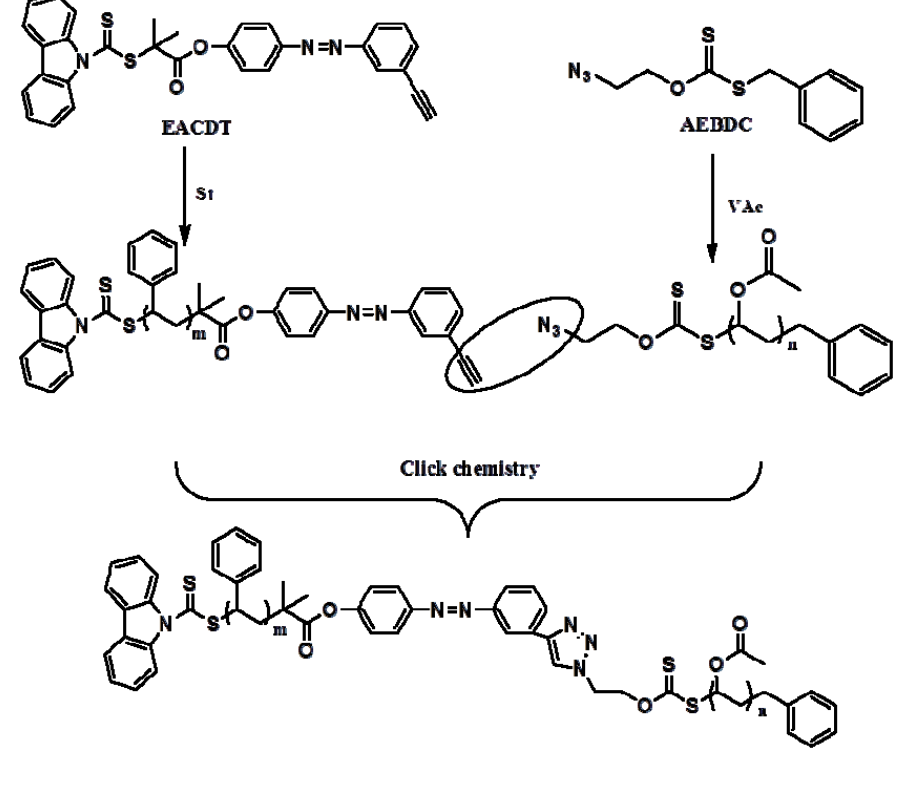
Figure 4. TEM pictures of 1/1 blend of unfunctionalized PVAc